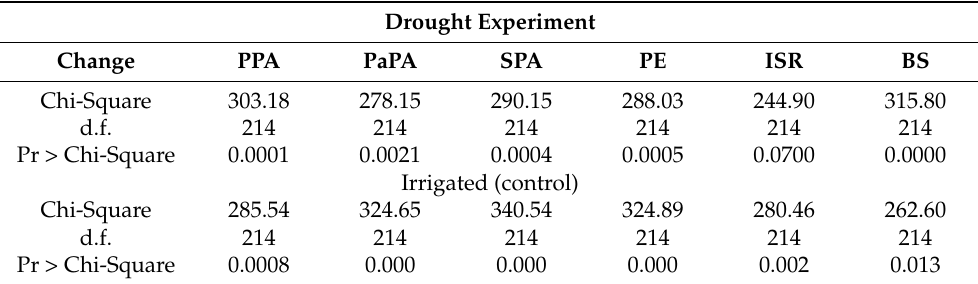
Kruskal-Wallis rank sum test for phenotypic acceptability and diseases cores for field experiments.